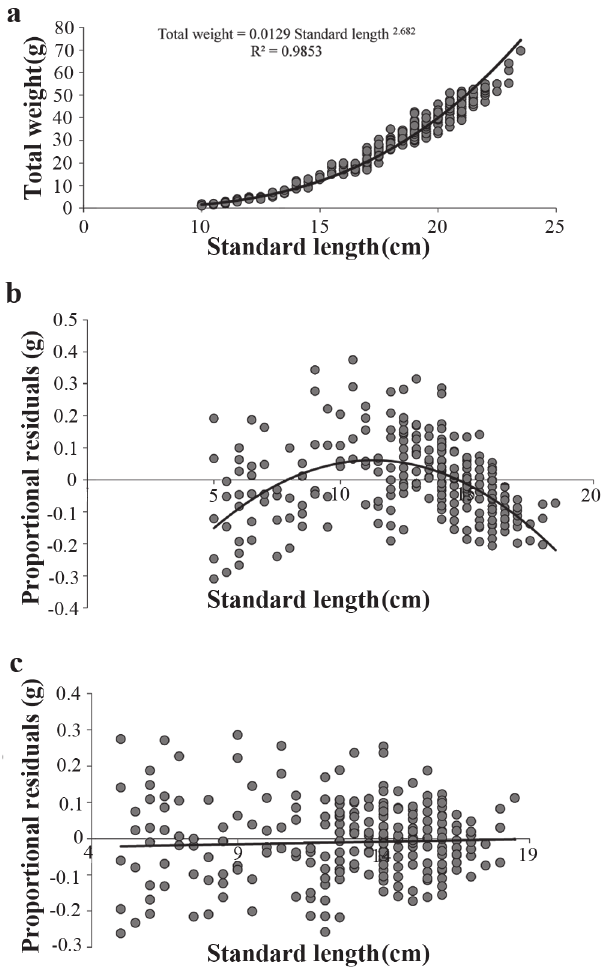
Maracanã River, Pará State.